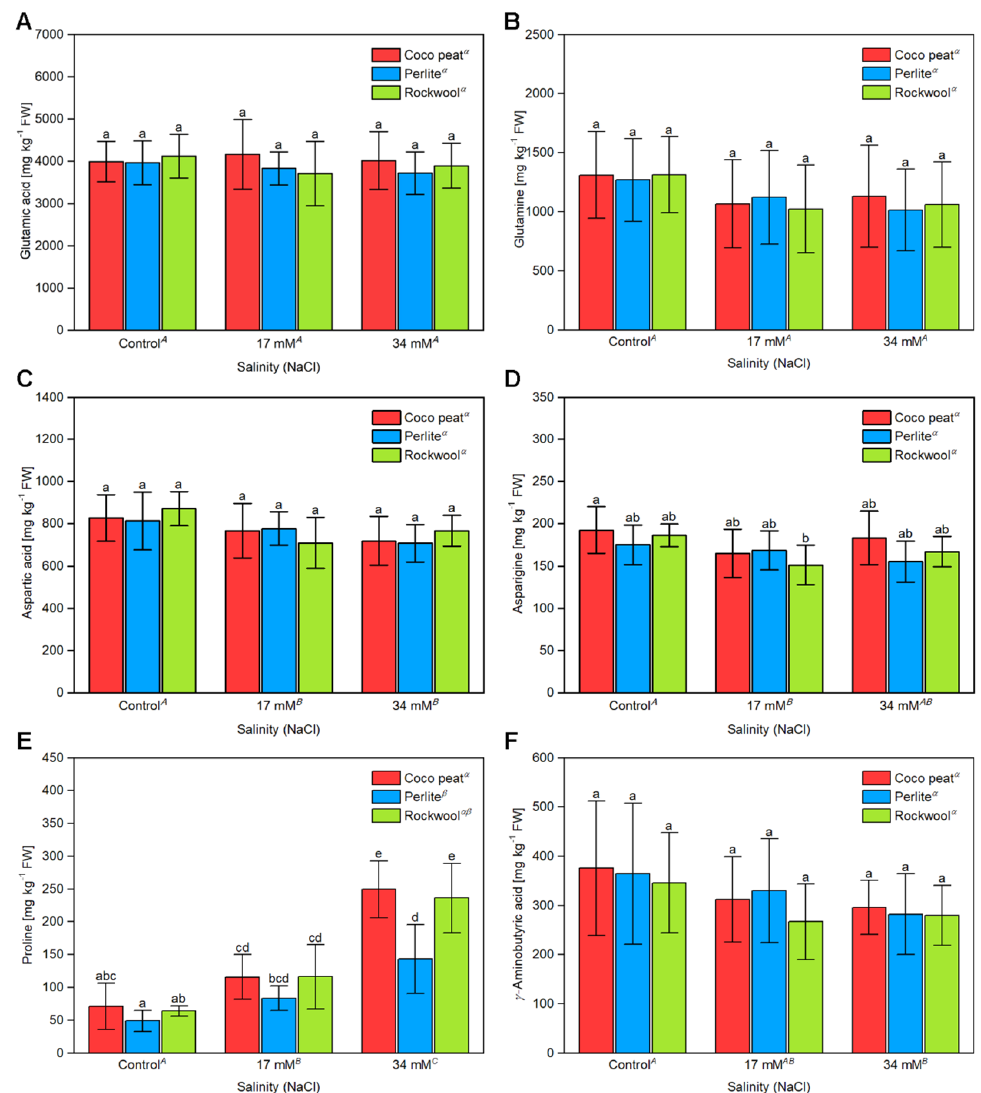
Figure 5. The content of free amino acids present in cherry tomato fruit grown in different substrates and salinity levels. The ( A ) glutamic acid, ( B ) glutamine, ( C ) aspartic acid, ( D ) asparagine, ( E ) proline and ( F ) γ -aminobutyric acid content of cherry tomato fruits from two harvests the 10th of September and 17th of October 2017 grown in coco peat, perlite and Rockwool under different levels of salinity in the nutrient solution. The error bars represent the SD. Upper-case letters compare the salinity treatments, Greek letters compare different substrates, lower-case letters within the graph compare single mean values of the treatments. The raw data are available in Supplementary File